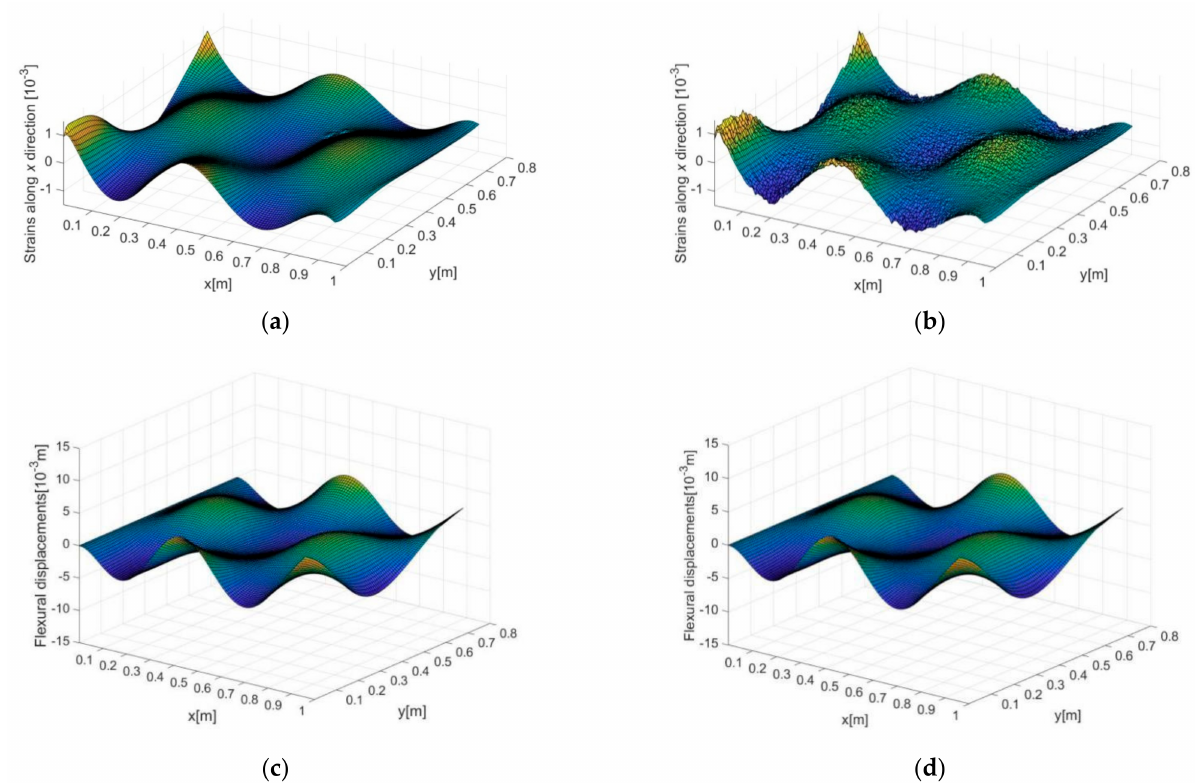
Figure 6. The strain distribution in the x direction ( a ) computed by direct FEM and then ( b ) contaminated using Equation (6) with noise level of 10%; the vibration displacements ( c ) computed by direct FEM and ( d ) reconstructed by iFEM based on strains in ( b ). The excitation frequency and size of the inverse elements are 200 Hz and 3 mm,